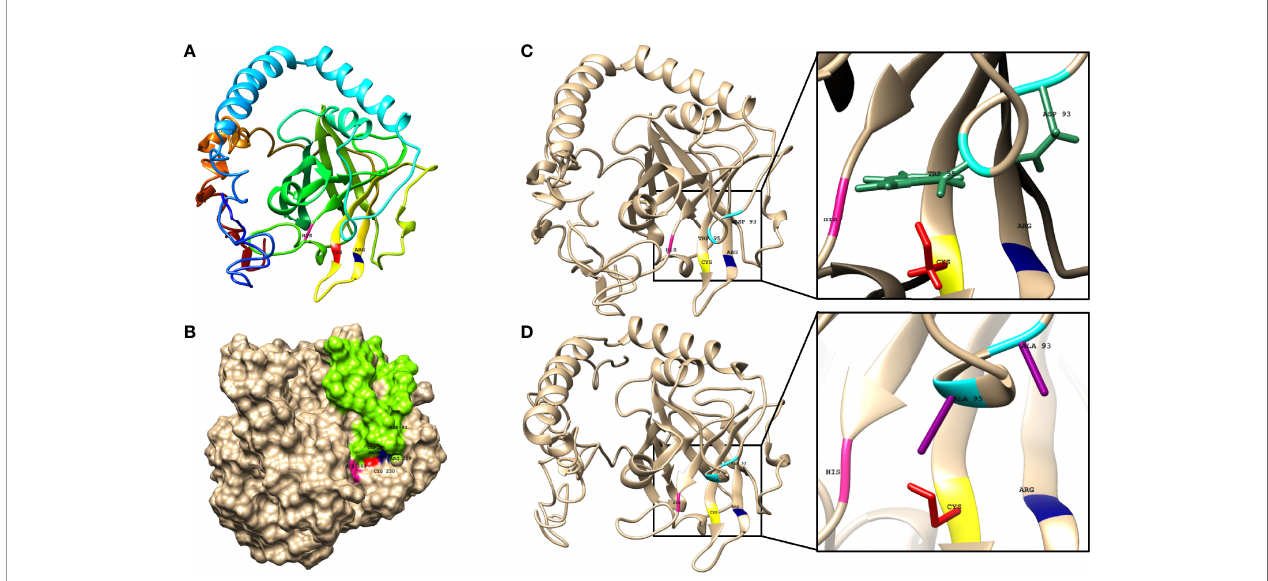
FIGURE 3 | The predicted structure of the C. striatum sortase C protein showing the presence of the putative active site triad essential for catalytic activity and a ‘ lid ’ . (A) The sortase C protein in ribbon form, showing the overall organization of the protein backbone in 3D space. The modeled structure reveals the presence of the putative Cys-His-Arg triad essential for catalytic activity. The Cys230 residue is shown in red, the His168 residue in pink, and the Arg239 residue in blue. The default ribbon style is smooth (rounded) (B) Surface representation of the class C sortase protein showing the sortase ‘ lid ’ (green) occluding the active site residues. Homology modeling was done using the I-TASSER server using the amino acid sequence of the sortase C protein retrieved from GenPept (ID: WP_034656562) (C) In the wild-type sortase C protein, the sortase ‘ lid ’ is predicted as a loop-like extension, in close proximity with the putative active site Cys-His-Arg (yellow-pink- blue) residues. The closer version of the region, predicts interactions between the aromatic ring of the Trp95 residue (green) and the Asp93 residue (green) of the ‘ lid ’ with Cys230 and Arg239 residues respectively (D) In the mutant sortase C protein (D93A/W95A), the lid is predicted to be displaced from the triad residues. In the closer version, a cavity is predicted between the mutated alanine residues (purple) and the putative active site triad. This ‘ semi-open ’ lid conformation of the sortase C protein was used for protein-peptide in silico molecular docking studies. Images made using UCSF